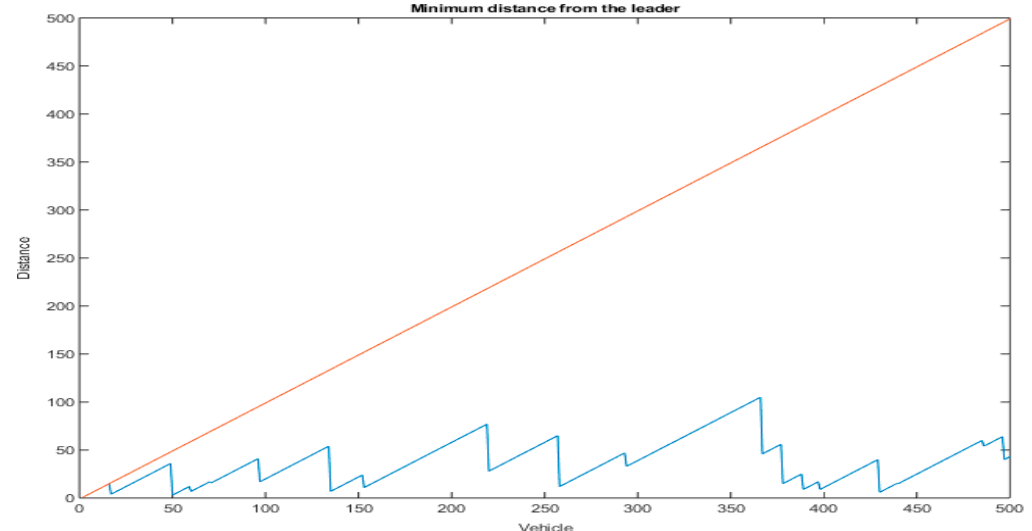
Figure 18. Minimum distance from the leader, for the standard and the small world model, plotted versus the vehicle number.